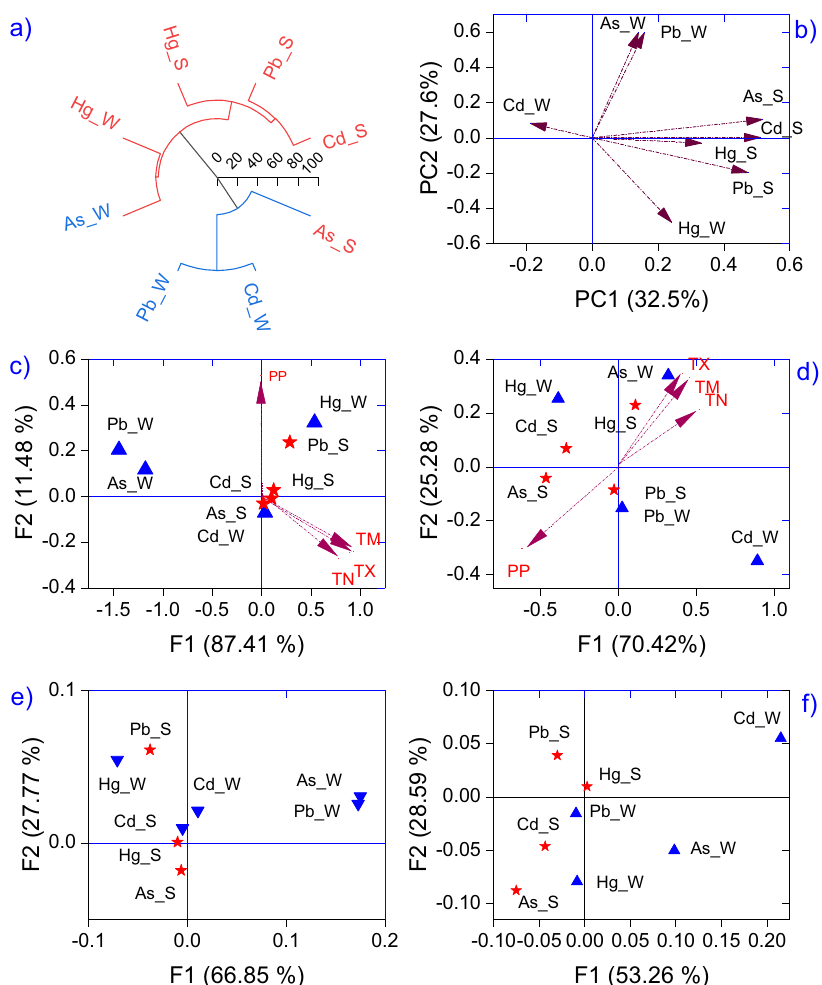
Fig. 5 The multivariate statistical results for heavy metals and climate data. a Dendrogram of hierarchical cluster analysis (HCA) based on similarities; b principal component analysis (PCA) to provide a grouping of variables; c canonical correspondence analysis (CCA) for 2018 datasets; d CCA analysis for 2019 datasets; e non-symmetrical correspondence analysis (NSCA) demonstrated high variability of data in 2018; f NSCA indicated insigni fi cant variability of data for ( p < 0.001) in